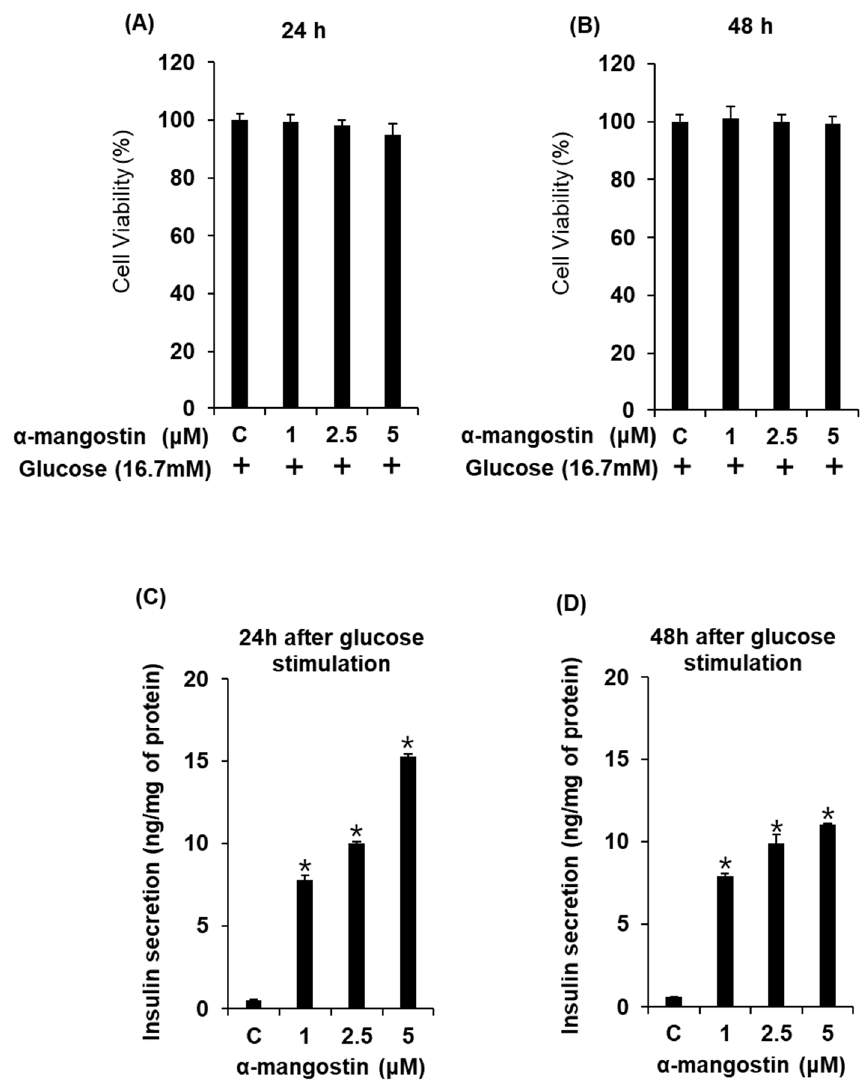
Figure 2. Effect of α -mangostin on viability and glucose-stimulated insulin secretion in INS-1 cells for various time points with high glucose. ( A ) Effect of α -mangostin on viability of INS-1 cells for 24 h. ( B ) Effect of α -mangostin on viability of INS-1 cells for 48 h. ( C ) Effect of α -mangostin on glucose-stimulated insulin secretion in INS-1 cells for 24 h. ( D ) Effect of α -mangostin on glucose-stimulated insulin secretion in INS-1 cells for 48 h. Insulin amount was normalized by total protein amount in the cell lysates. * p < 0.05 compared to the control value.